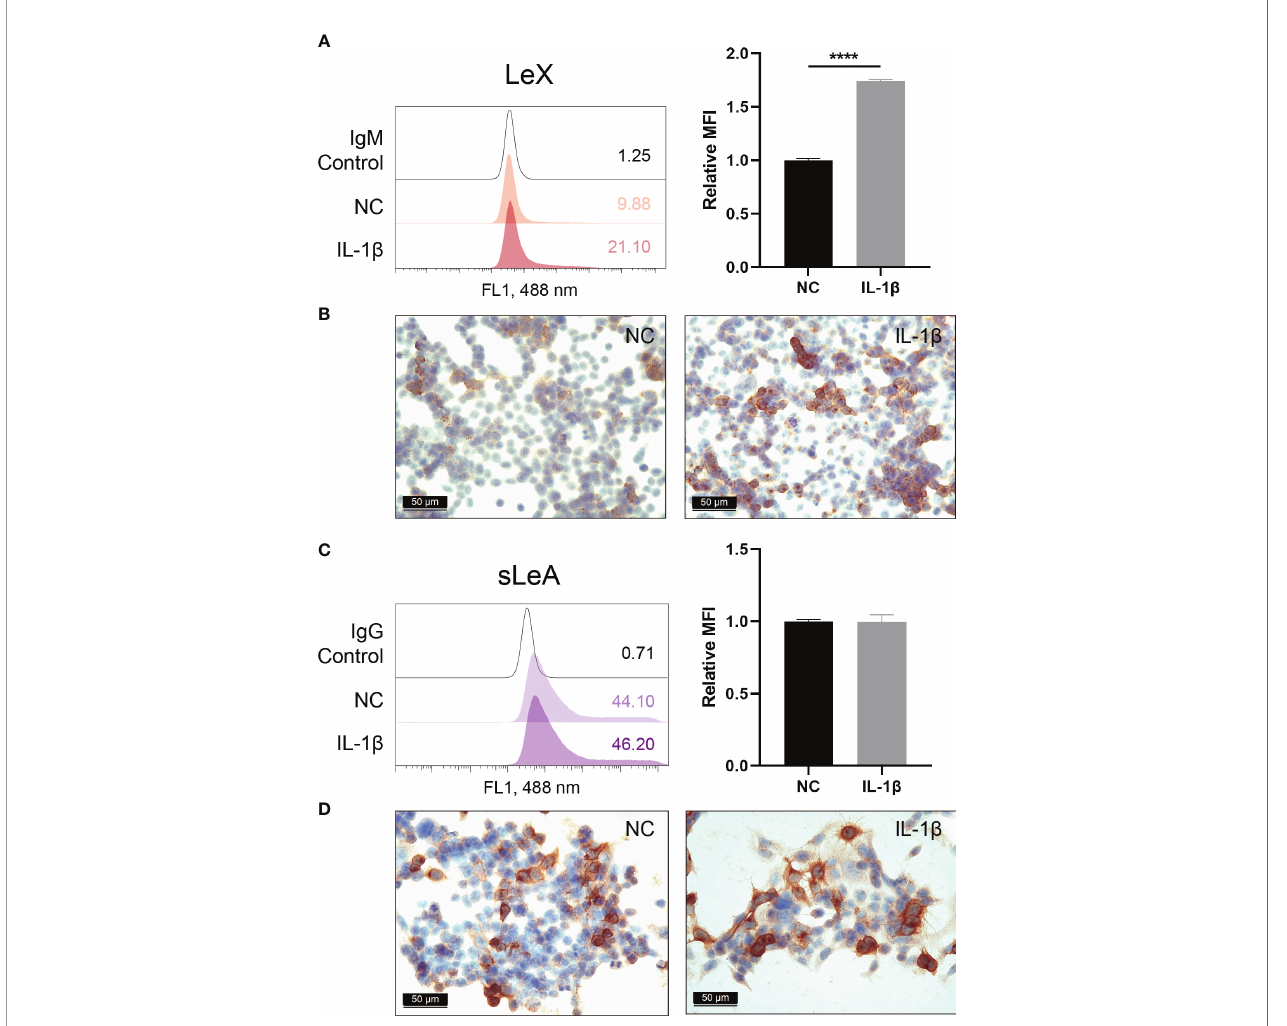
FIGURE 8 | Cell surface expression of LeX and sLeA after IL-1 b treatment in RL95-2 cells. Flow cytometry detection of LeX (A) and sLeA (C) , relative mean fl uorescence intensity (MFI) is used for statistical analysis, numbers inside the frame denote the positive cells (%) in a representative experiment. Immunocytochemical staining of LeX (B) and sLeA (D) in RL95-2 cells without and with IL-1 b treatment (20ng/ml). Statistical analysis was performed in three independent experiments by t test. Error bars, S.E.M. NC, untreated. **** P <